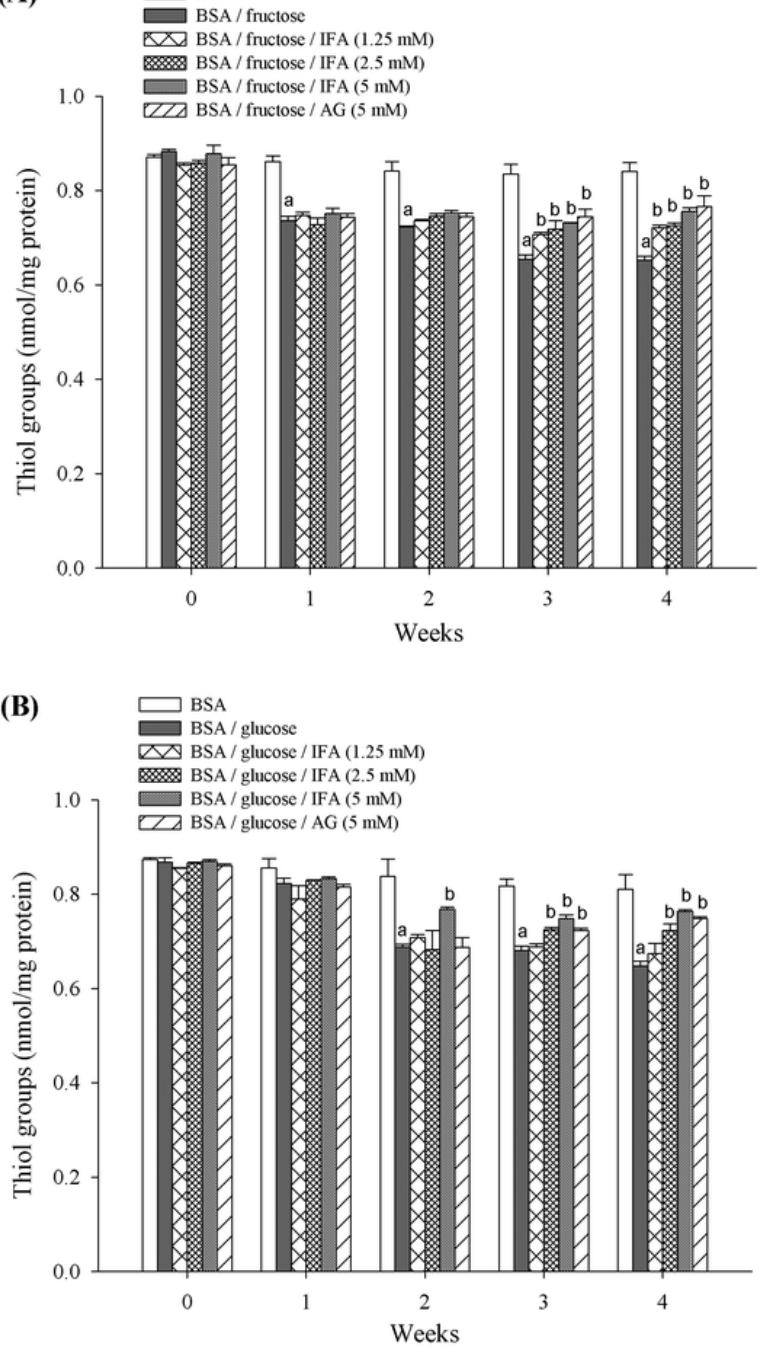
Figure 6. The effect of IFA on protein thiol formation in BSA/fructose and BSA/glucose systems. Results are expressed as mean ± SEM (n = 3). a p < 0.05 when compared to BSA, b p < 0.05 when compared to BSA/fructose or